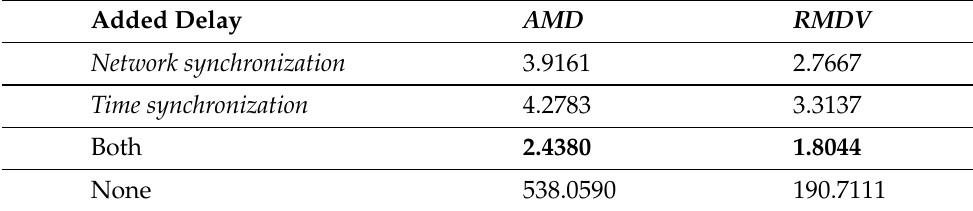
Table 3. Errors of 45 FPS according to delay